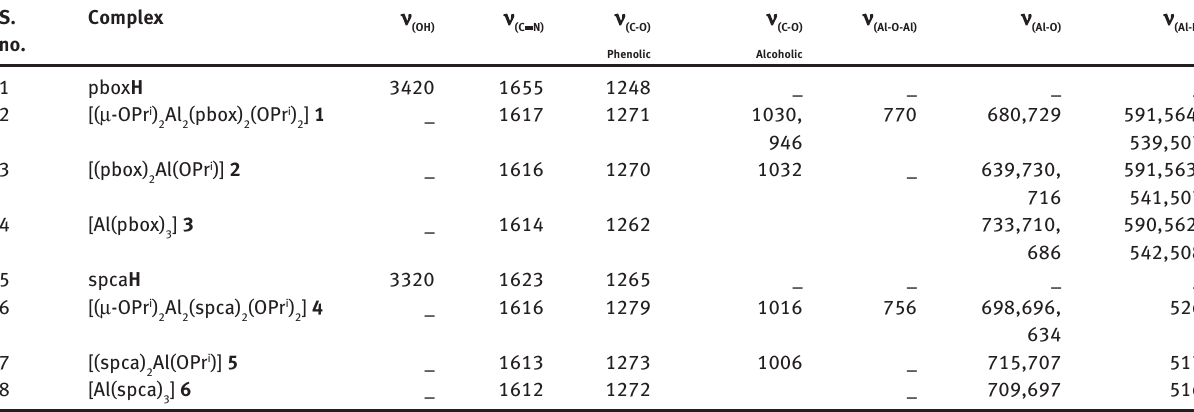
Table 2: Characteristic IR frequencies (cm -1 ) of Schiff base and their aluminium(III) complexes. S.